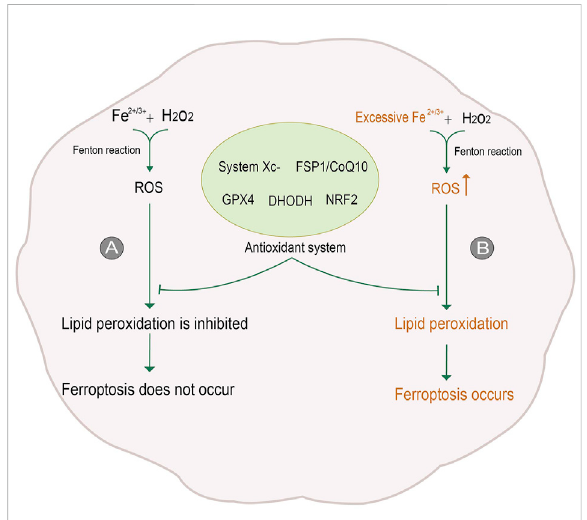
FIGURE 1 Process of ferroptosis. (A) In general, Reactive Oxygen Species (ROS) is generated by iron ions and hydrogen peroxide in cells through the Fenton reaction. ROS is removed under the action of the antioxidant system, inhibiting lipid peroxidation andthusavoidingferroptosis. (B) Whenintracellularironlevelsrise, excessive ROS will be produced. The antioxidant system is not enough to counteract the excessive ROS, so lipid peroxidation is not inhibited, and ferroptosis occurs. The fi gure modi fi ed from (Yan et al.,